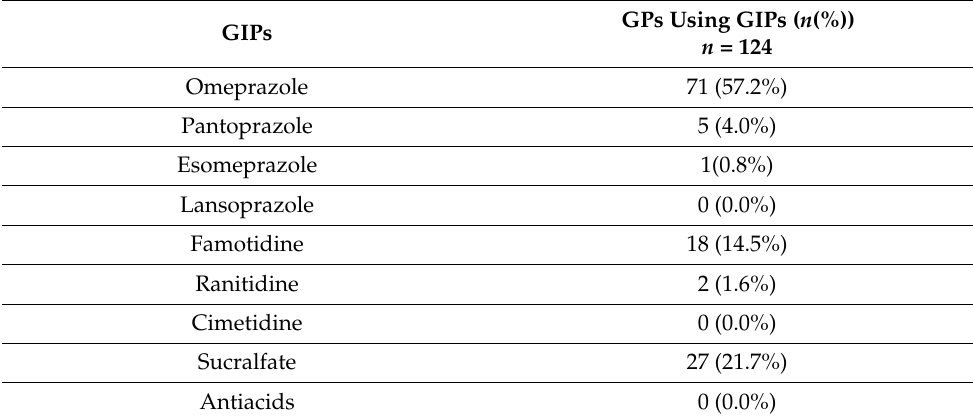
Table 1. Choices of Portuguese small-animal GPs concerning the most frequently prescribed GIPs. GPs Using GIPs ( n GIPs